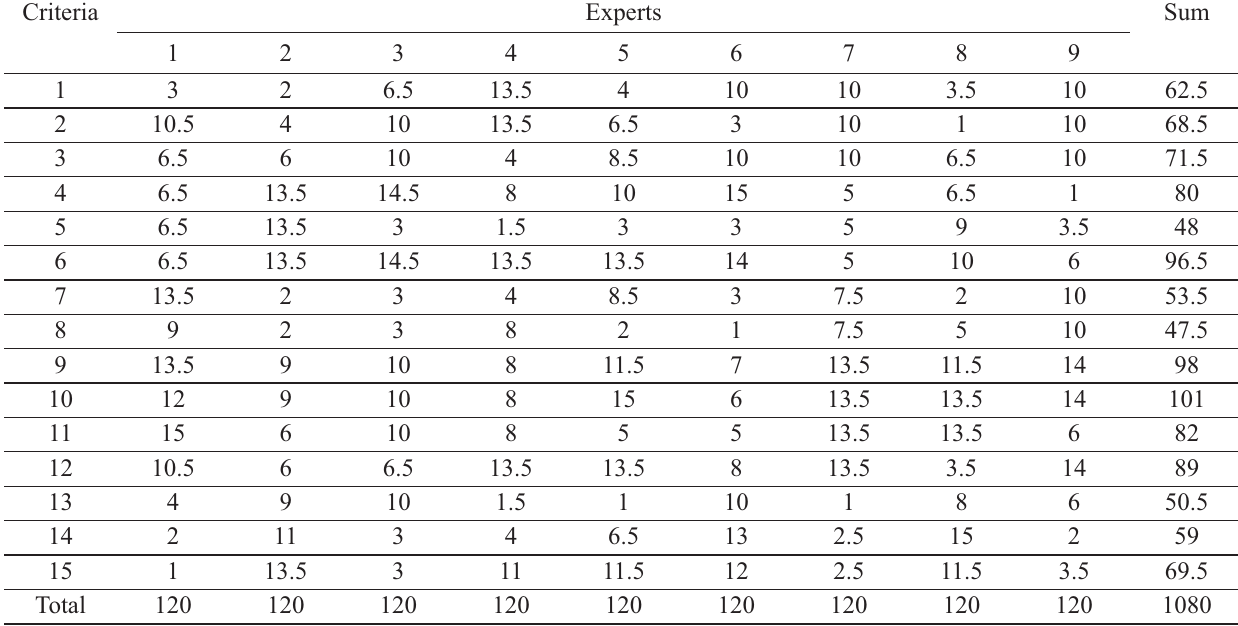
Table 7. Ranking of experts’